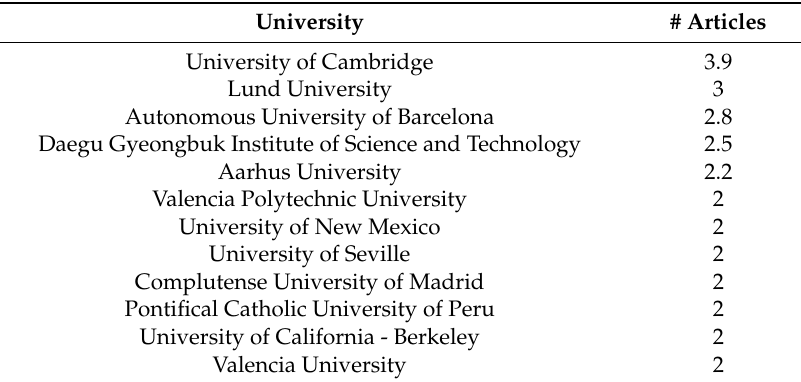
Table 6. Top universities.